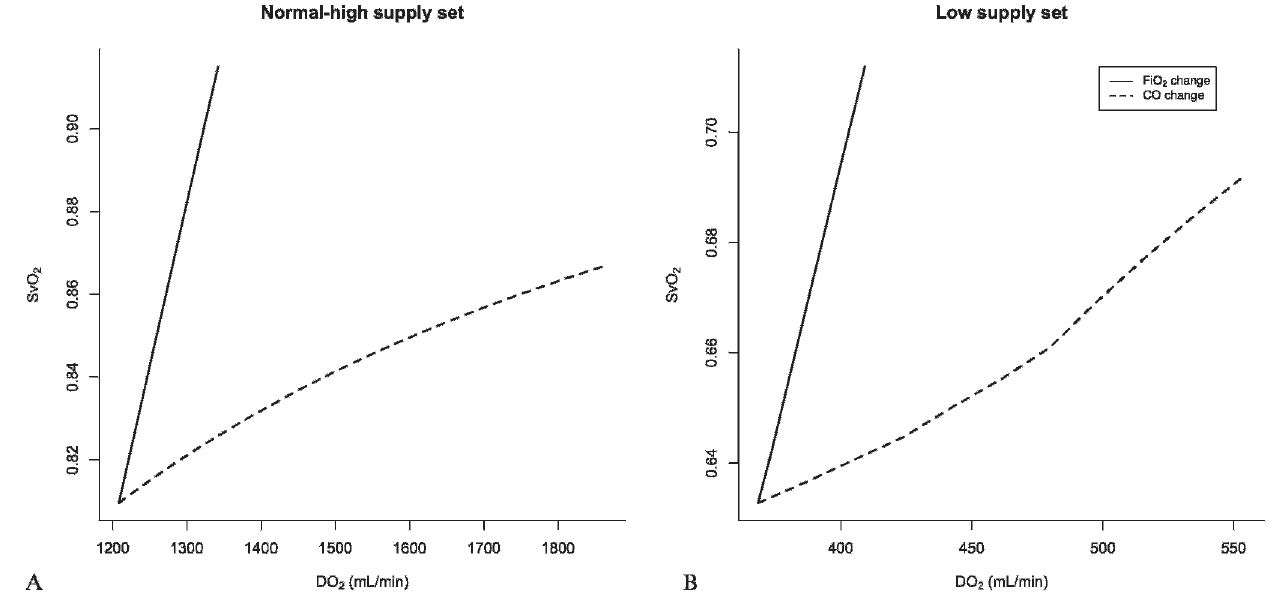
Figure 1 - Panel A : Effect of increasing DO 2 on the SvO 2 through changes in the inspired fraction of oxygen (FiO 2 , solid line) or cardiac output (dashed line) under normal and high oxygen supply conditions sufficient to attain optimal oxygen consumption in all peripheral compartments. Panel B : Effect of increasing DO 2 on the SvO 2 through changes in the inspired fraction of oxygen (FiO 2 , solid line) or cardiac output (dashed line) under low oxygen supply conditions that caused the oxygen consumption to be supply